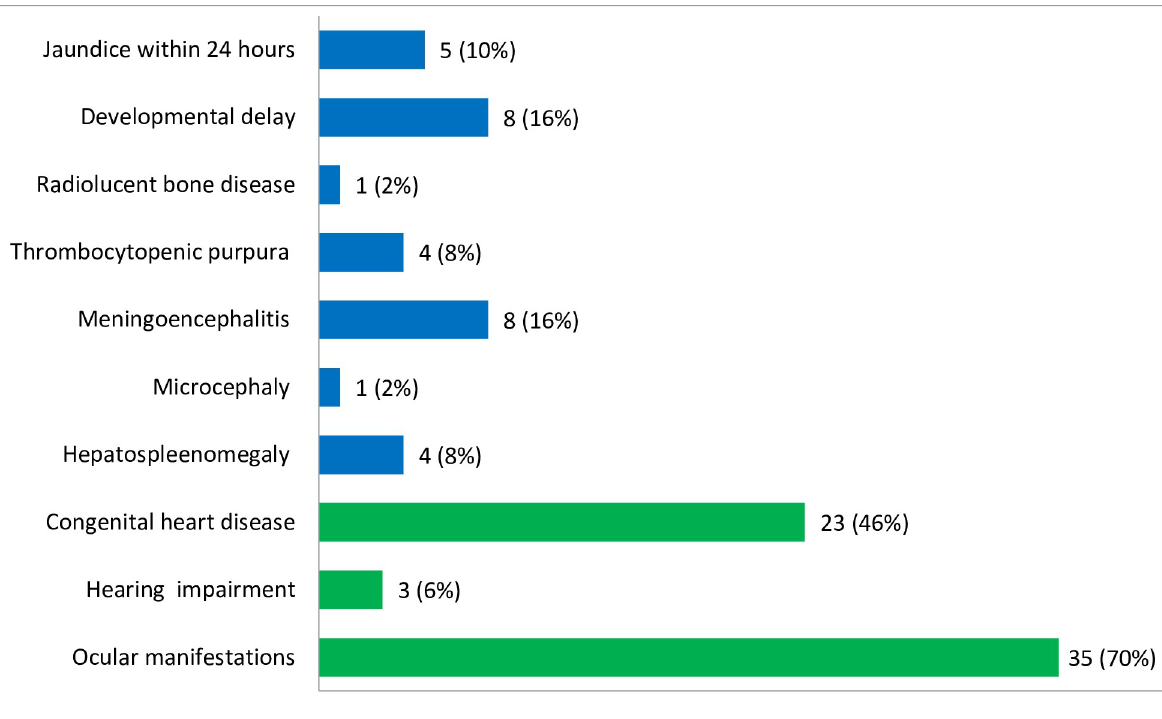
Fig 1. The frequency of different clinical manifestations among infants suspected for CRS in Amhara Regional State Referral Hospitals, Northwest Ethiopia, December 2015-August 2017. The green and blue colors in the bar chart indicate the frequency of each major and minor clinical manifestation of CRS suspected cases,